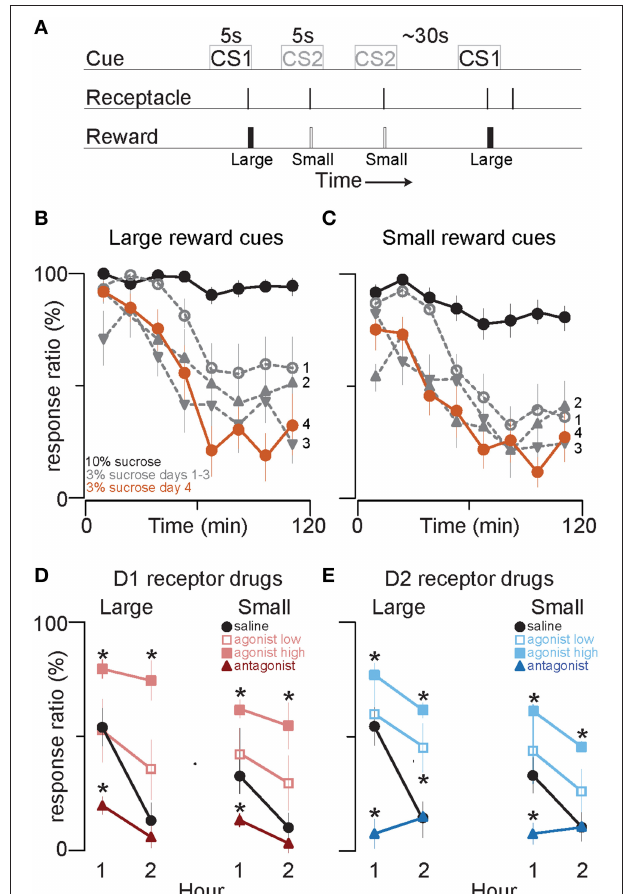
FIGURE 1 | D1 and D2 receptor agonists and antagonists, respectively promote and attenuate cued approach to reward. (A) 2CS + task schematic. Time is not to scale. (B,C) Single session average response ratio (% of cues responded to) in 15min time bins to cues that predict large (B) and small (C) volumes of 10% sucrose (black line), and the first three (gray) and fourth (orange) days after the switch to equivalent volumes of 3% sucrose reward. (D) Symbols show the mean response ratios to cues that predict 250 µ l (“Large”) or 150 µ l (“Small”) of 3% sucrose reward after injection of saline (black circles), low (red open squares) and high doses (light red squares) of the D1 receptor agonist SKF 81927, and of the D1 antagonist SCH 23390 (dark red triangles), into the NAc core. The bold lines connect the response ratio data from the first and second hour of the behavioral session. (E) The graph follows identical conventions to those in (D) for injection of saline (black circles), low (blue open squares) and high dose D2 receptor agonist quinpirole (light blue squares) and D2 antagonist raclopride (dark blue triangles) into the NAc core. Error bars in this and all subsequent figures denote SEM. * p < 0.05 compared to saline. See Table 1 for all statistical results. See Methods Section Drugs for drug